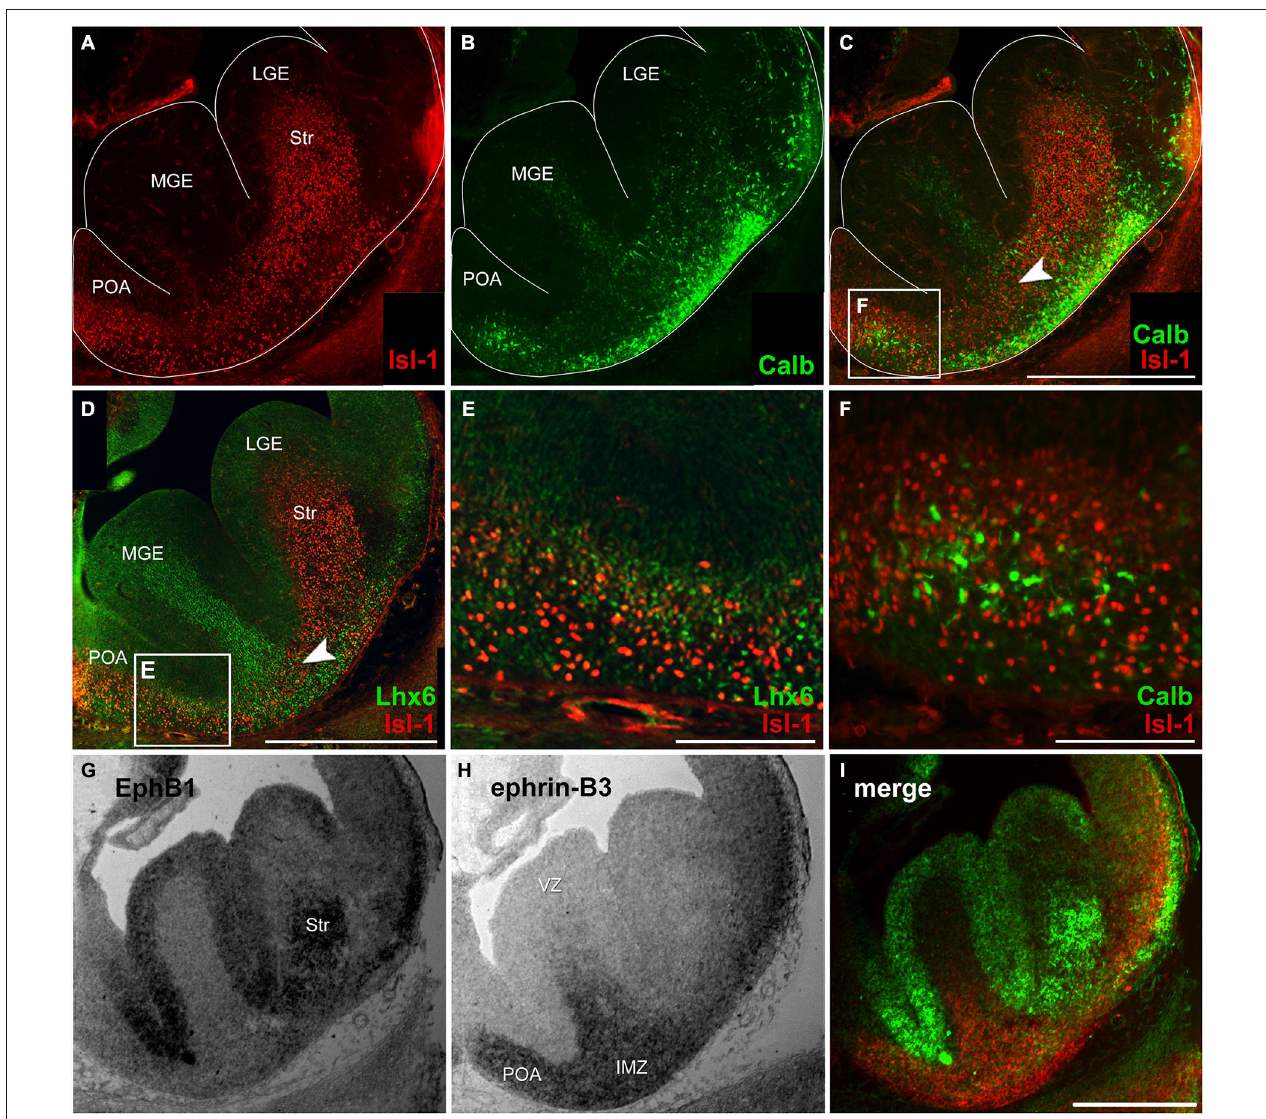
situ hybridization with EphB1 and ephrin-B3 riboprobes was performed on alternating coronal E14 brain slices reveals EphB1 labeling (G) of the developing striatum (Str) as well as the ventricular zone (VZ) of the lateral (LGE) and medial ganglionic eminence (MGE)—regions that are avoided by cortical interneurons. (H) Ephrin-B3 is strongly expressed in the POA and the intermediate zone (IMZ) ventral the striatum. (I) Pseudocolor overlay of G (green) and H (red) directly illustrates the complementary expression of EphB1 and ephrin-B3. Lateral is right and medial is left. IMZ, intermediate zone; LGE, lateral ganglionic eminence; MGE, medial ganglionic eminence; POA, preoptic area; Str, Striatum; VZ, ventricular